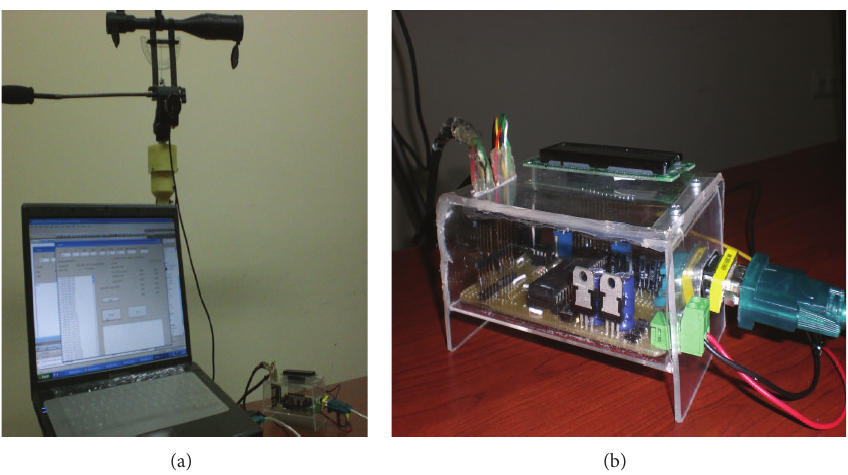
Figure 9: The implemented device for shading analysis (a). Interface card (b).